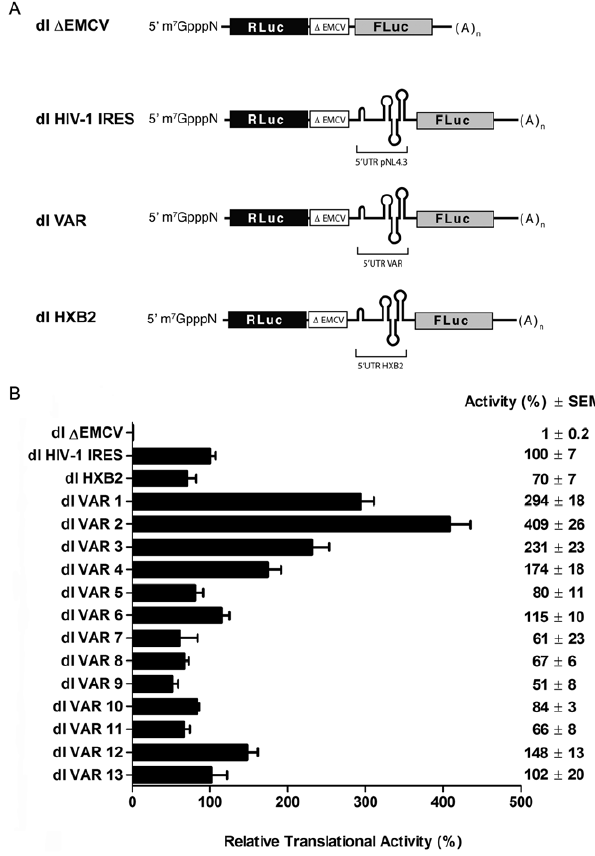
Figure 1. Translational activity of the natural HIV-1 5 9 UTR variants isolated from clinical samples. (A) Schematic representa- tion of the bicistronic vectors (mRNAs) used in this study. Vectors dl D EMCV and dl HIV-1 IRES have been previously described [10,25]. The HIV-1 5 9 UTRs recovered from the HXB2 infectious clone or from RNA isolated from clinical samples were cloned into dual luciferase bicistronic (dl) vectors harboring Renilla (RLuc) and Firefly (FLuc) luciferases as reporter genes to generate the dl VAR and dl HXB2 vectors. The dl VAR vectors were arbitrarily numbered 1-13. The 5 9 UTR recovered from the HIV-1 infectious clone pNL4.3, dl HIV-1 IRES, was used as the reference IRES [10], while the RLuc/FLuc bicistronic vector harboring a defective encephalomyocarditis virus ( D EMCV) IRES, dl D EMCV, was used as a negative control [10,25]. (B) Bicistronic vectors were transfected into HeLa cells, which were processed 24 h thereafter. RLuc and FLuc activities were measured and the [(FLuc/RLuc)] ratio was used as an index of IRES activity, with the [(FLuc/RLuc)] ratio of the dl HIV-1 IRES arbitrarily defined as 100%. Values are the means + /- SEM from three independent